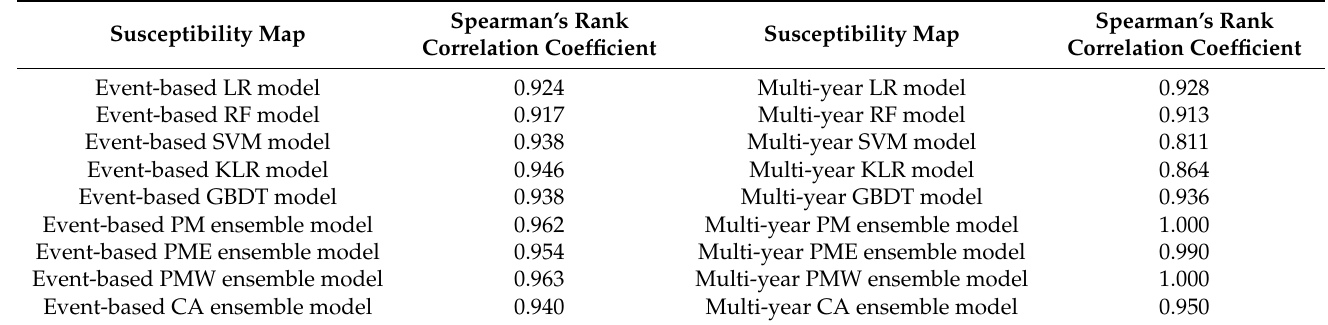
Table 13. Degree of difference between the susceptibility maps of the multi-year PM ensemble model and other